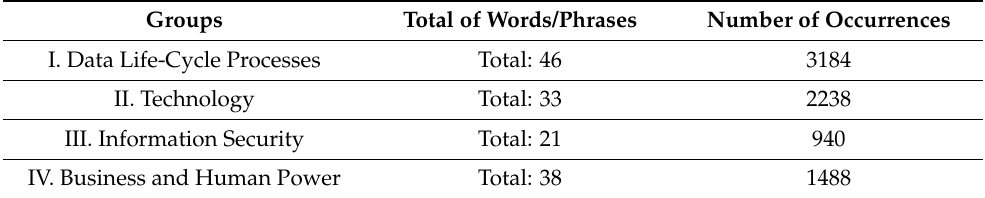
Table 5. Main big-data management